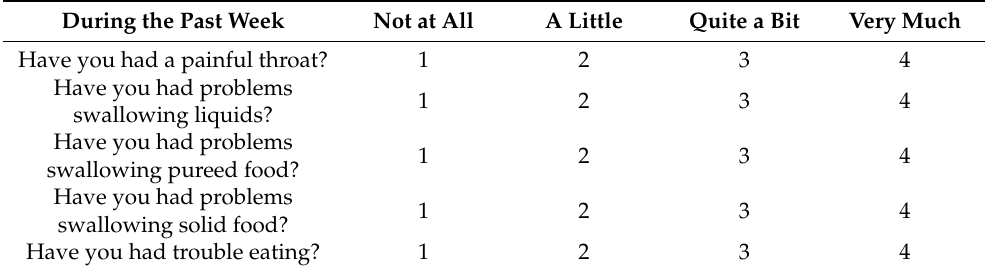
Table 1. Five selected items related to dietary function from the European Organization for